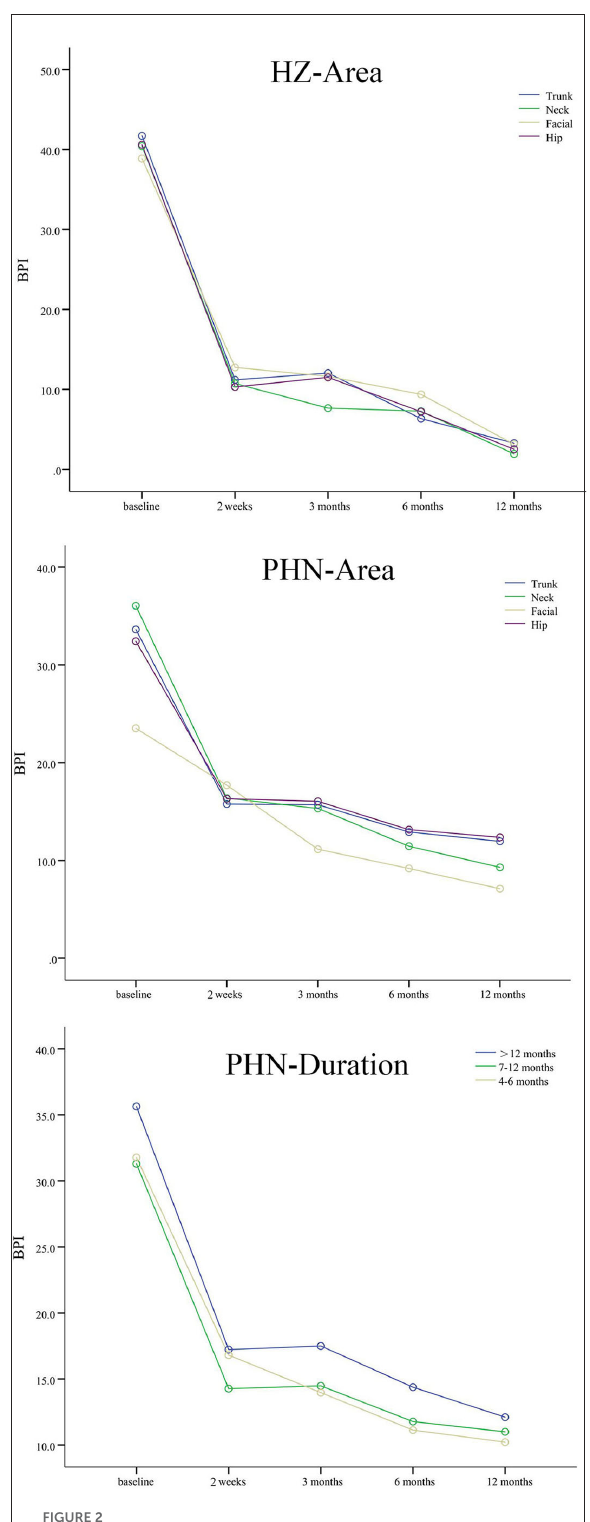
FIGURE2 The BPI scores of patients with HZ and PHN. Different colored lines mean different pain areas and durations. The BPI scores decreased significantly from baseline to 2 weeks, 3, 6, and 12 months after interventions in patients with different pain durations and